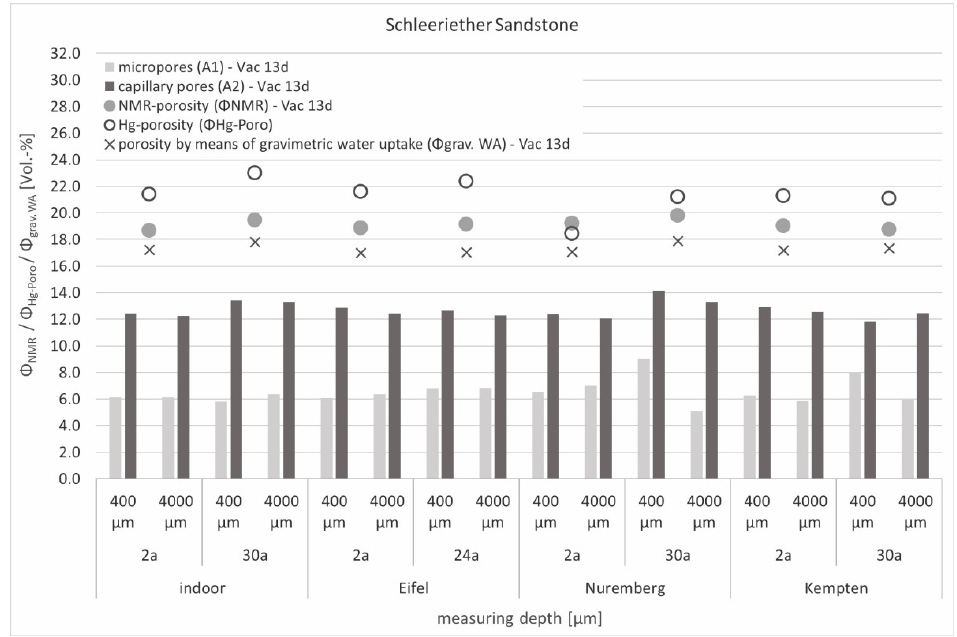
Figure 8. Distribution of micro (A1) and capillary (A2) pores within the Schleeriether Sandstone samples that were measured in the near-surface area (400 µm) and the sample depth (4000 µm), and presentation of the resulting NMR-porosity ( Φ NMR ) (averaged over the entire depth of the samples) in comparison with the detected porosity measured using mercury porosimetry ( Φ Hg-Poro ) and gravimetric water uptake ( Φ grav . WA ).